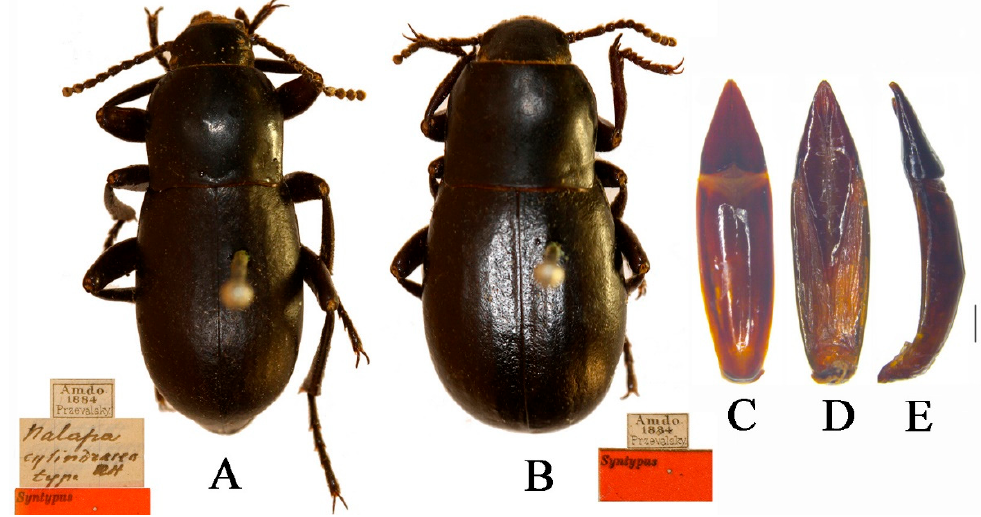
Figure 1. Nalepa cylindracea. ( A , B ) Habitus: ( A ) male; ( B ) female. ( C – E ) aedeagus: ( C ) dorsal view; ( D ) ventral view; ( E ) lateral view. Scale bars: 1.0 mm. Larva.